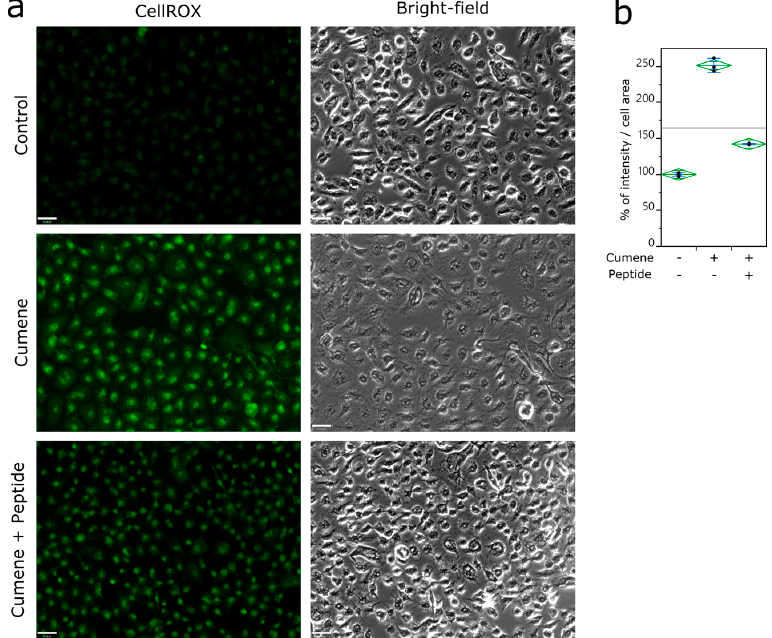
Figure 5. Ubiad1 protect keratinocyte from membrane-soluble cumene hydroperoxide. ( a ) Cellular Reactive oxygen species (ROS) detection in keratinocyte exposed 1 h to 200 µM cumene hydroperoxide using the CellROX green assay (x20 objective lens, scale bar = 31 µm); ( b ) CellROX quantification graph with One-Way Analysis of Variance, displaying confidence interval means diamonds (green). The line across each diamond represents the group mean. The vertical span of each diamond represents the 95% confidence interval for each group. Grand sample mean is represented by a horizontal black line.